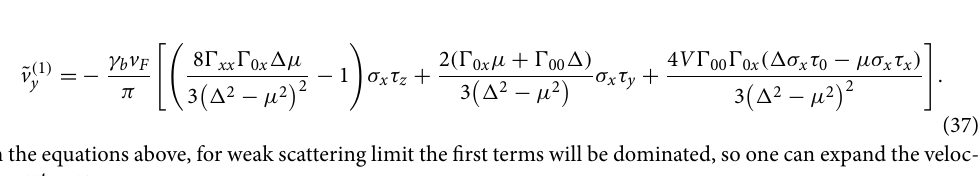
Figure 10. The vertex correction δ in the fBA and SCBA methods as a function of the µ for different values of M with ( a ) V = 0 , ( b ) V = 0.2 , ( c ) V = 0.4 , and ( d ) V = 0.6 . Here, the disorder parameter is γ b = 0.2